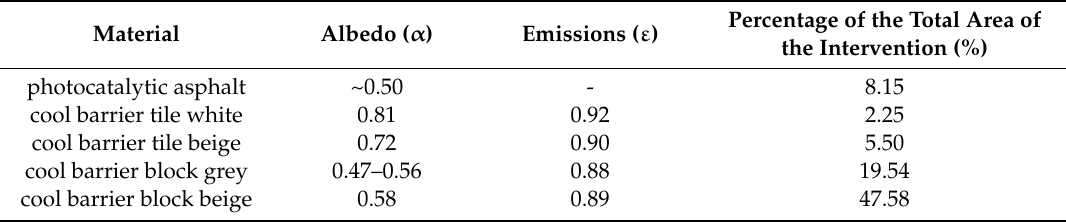
Table 2. The surface properties of cool pavement innovative materials on certificates from the University of Athens Kapodistrian authorized